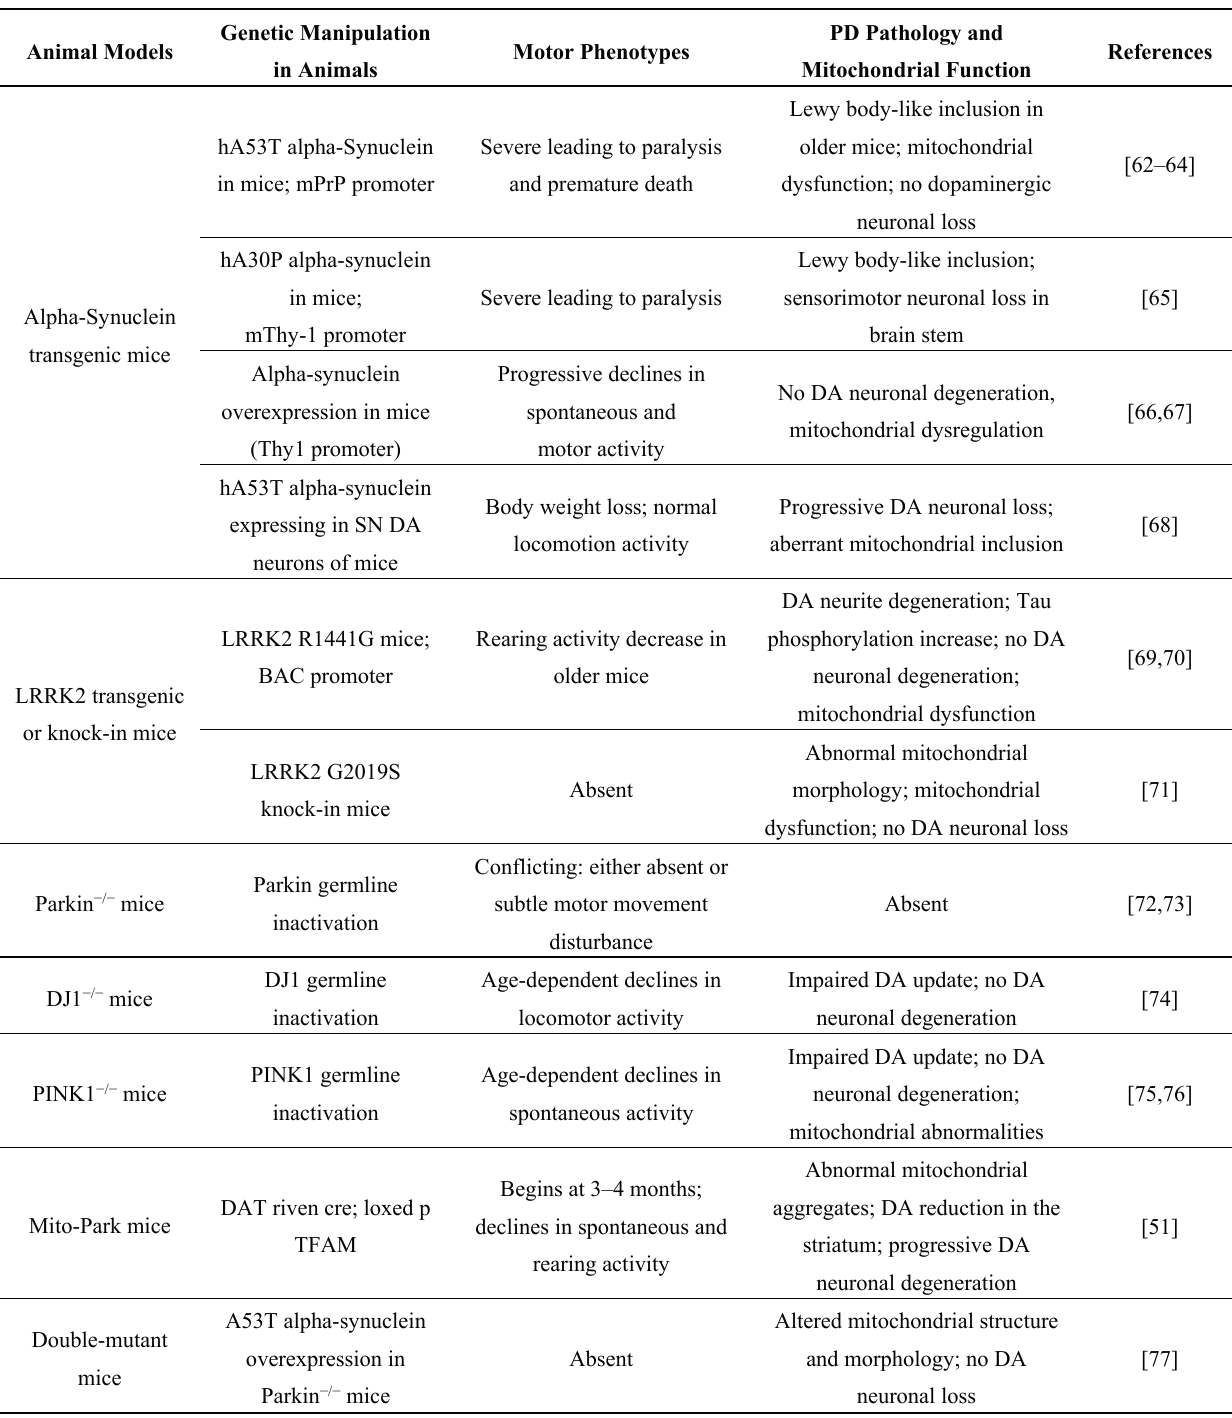
Table 1. Animal models of Parkinson’s disease (PD)-related genes affect mitochondrial